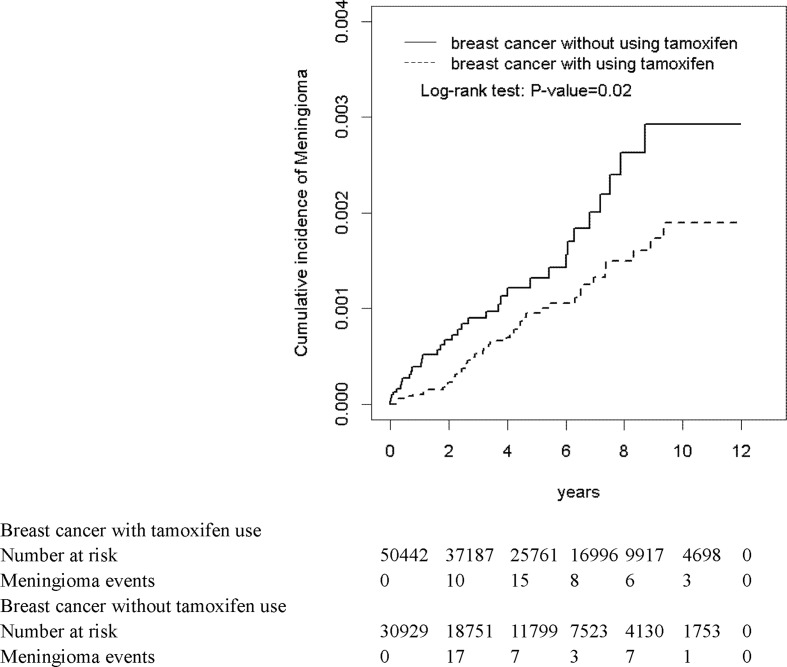
Cumulative incidence curves of meningioma for breast cancer with and without tamoxifen use.